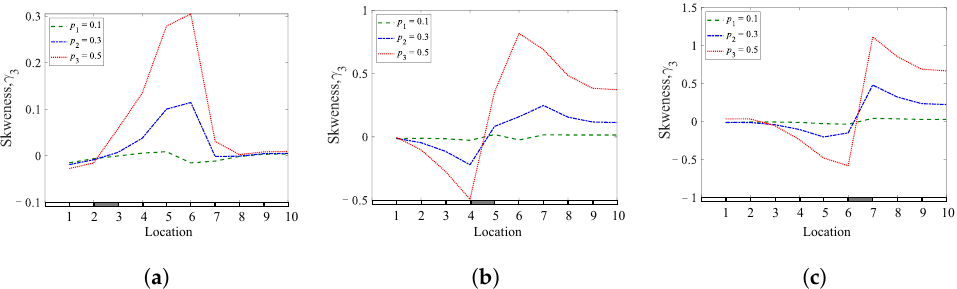
Figure 13. Skewness coefficients of a cantilever, simply supported beam for different crack depths and locations: ( a ) q 1 = 0.25; ( b ) q 2 = 0.45; ( c ) q 3 =